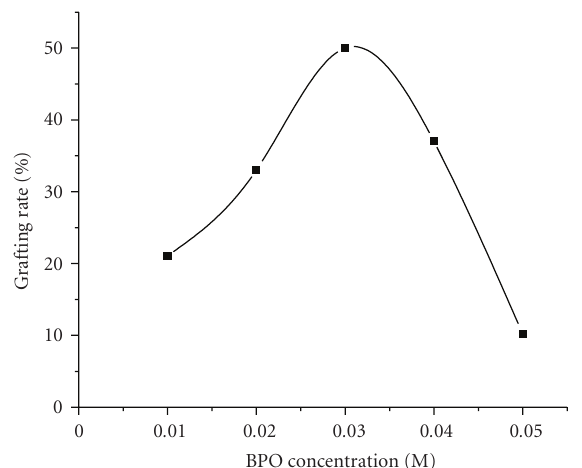
Figure 3: E ff ect of Temperature on Percentage of grafting, [MMA] = 10%(V/V) ; [BPO] = 0.03 M; [Reaction time] = 120 minutes; [Nitrogen atmosphere] = 20 minutes; Optimum [Temperature] = 70 ◦